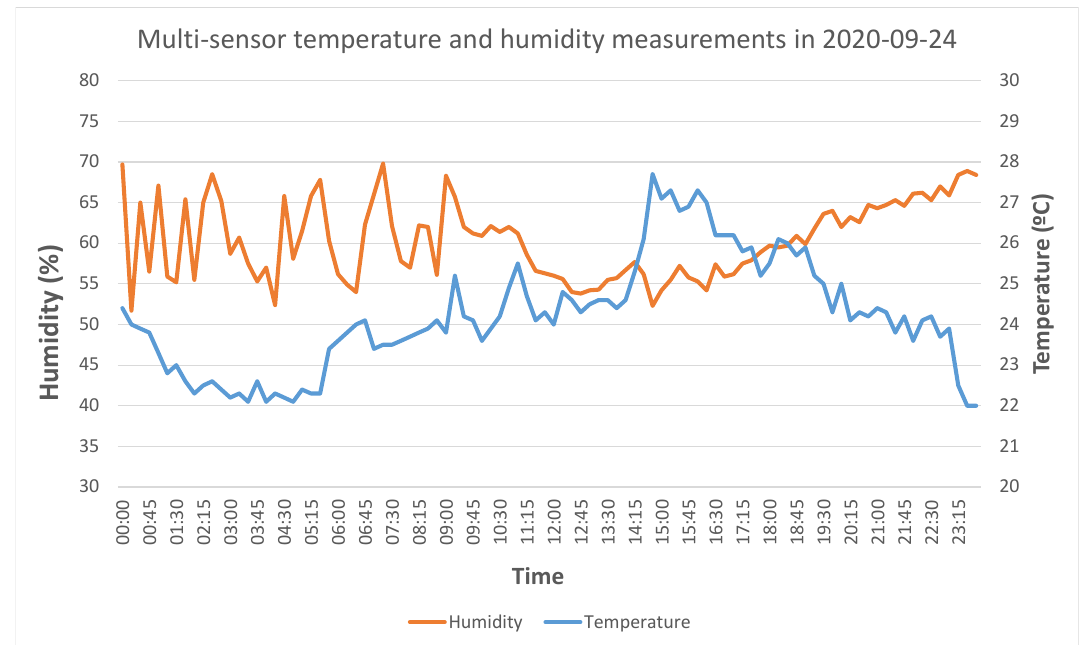
Figure 6. Multisensor measurements for temperature and humidity on 24 September 2020.